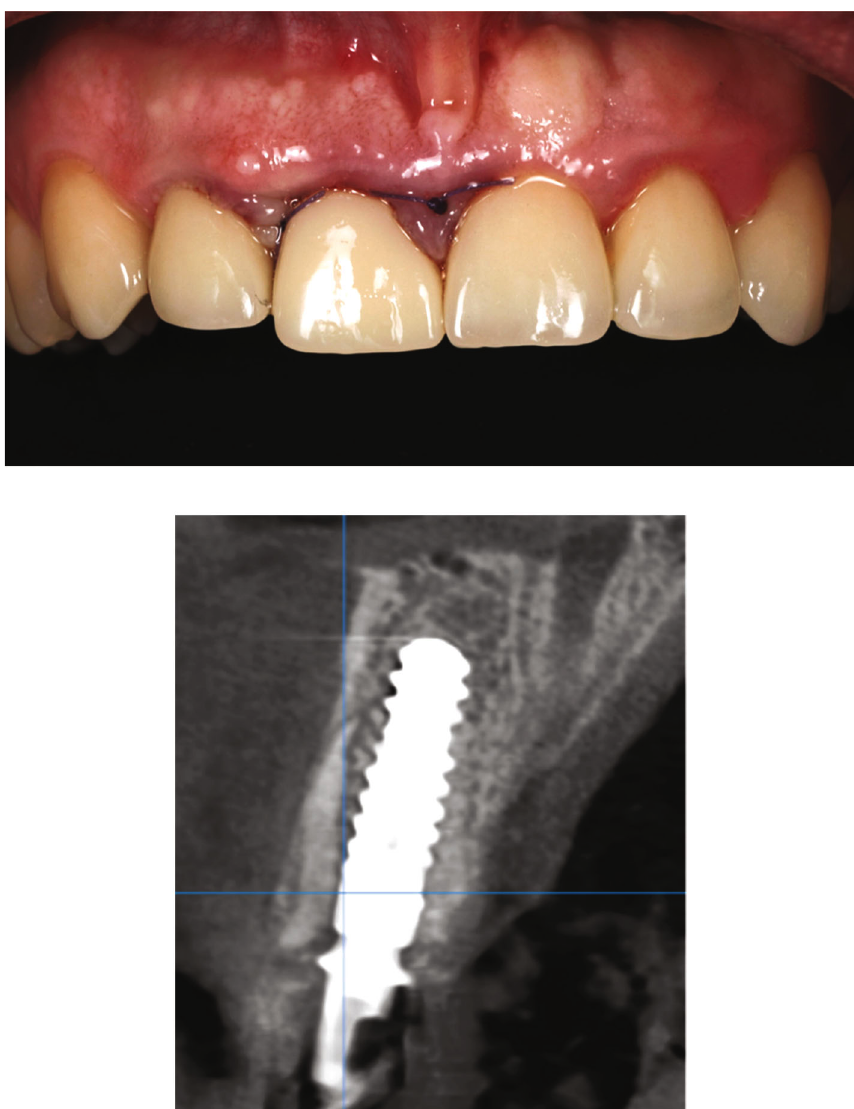
Figure 11: Immediate post-operative with fi tted immediate crown and